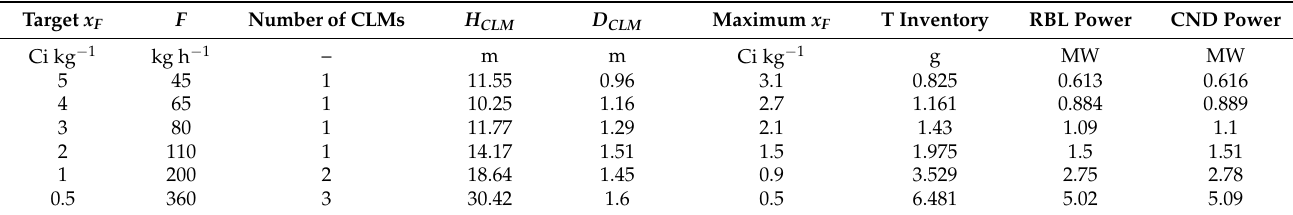
Table 2. Main features of CPS components for different tritium concentration